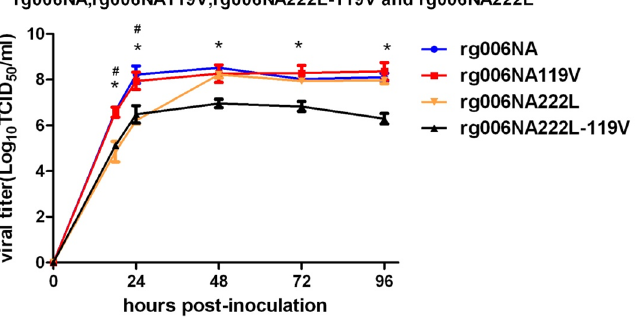
Figure 1. Replication kinetics of mutant recombinant highly pathogenic H7N9 avian influenza viruses in MDCK cells. Cells were inoculated with the recombinant viruses at 37 °C, and culture supernatants were harvested at 0, 18, 24, 48, 72 and 96 h post-inoculation (hpi). Virus titers were determined on MDCK cells. Growth curve of rg006NA in MDCK cells was in blue, round; rg006NA119V virus was in red, square; rg006NA222L virus was in orange, triangle; rg006NA222L-119V virus was in black, triangle. Each data point represents the mean log 10 ± SD TCID 50 /ml from at least two independent tests. # P < 0.05. *P <